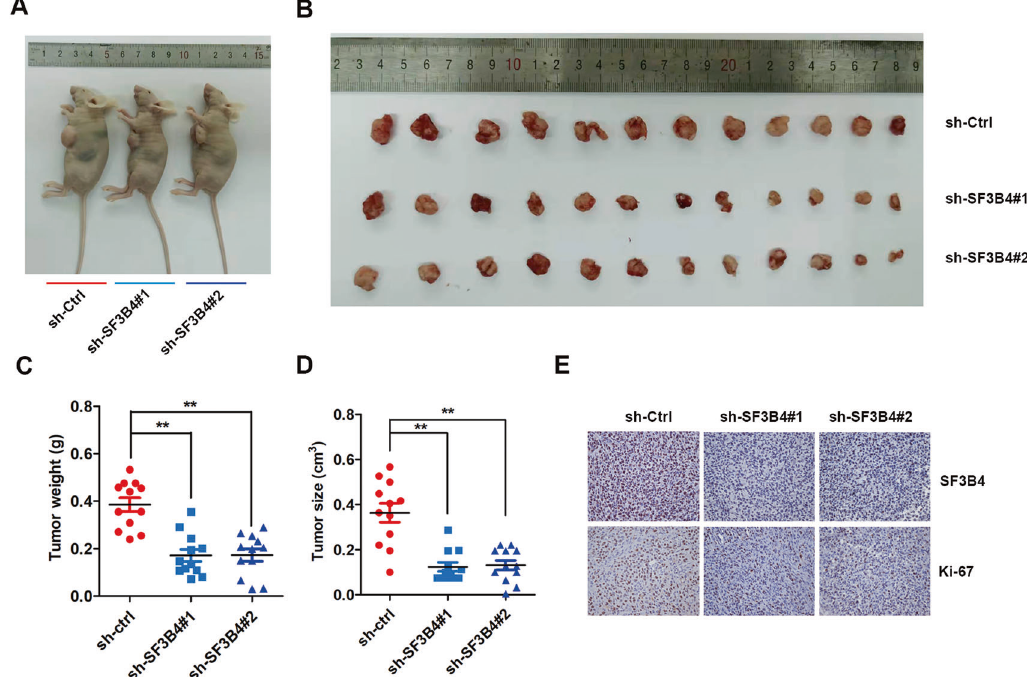
Fig. 3 Knockdown of SF3B4 suppresses xenograft tumor growth in vivo. A , B Images of tumors isolated from subcutaneous implantation of six nude mice bilaterally with SF3B4 knockdown and control HEY cells ( n = 12 per group). C Tumor weight statistics. D Tumor size statistics. E Immunohistochemical staining images of SF3B4 and Ki-67 in xenograft tumors from SF3B4 knockdown and control cells treated nude mice. P -value was obtained by Unpaired t -test. Results represent the mean ± SD. * P < 0.05, ** P <